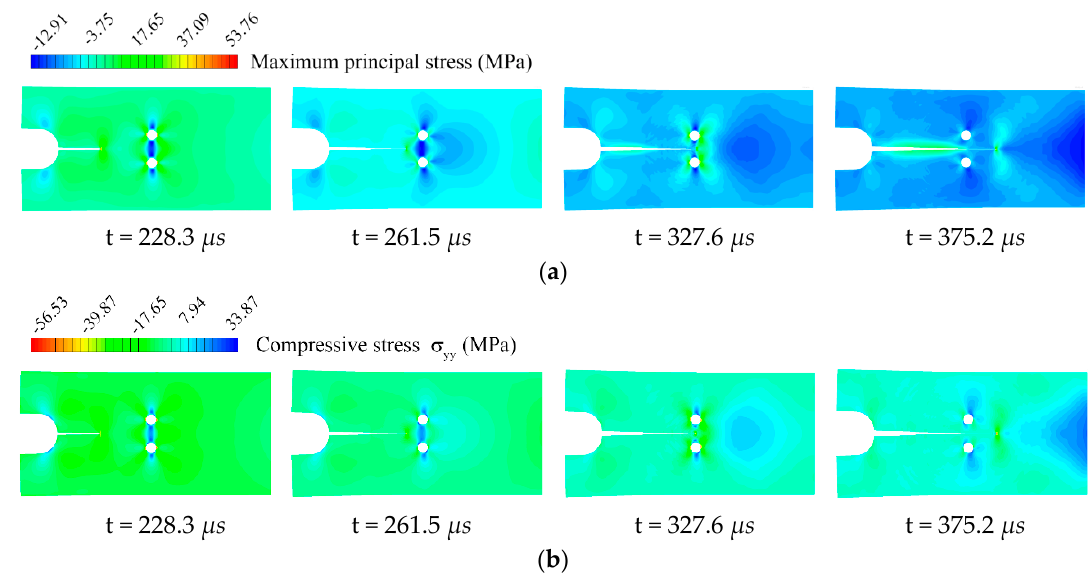
Figure 14. Numerical (AUTODYN) results of B16-D30 specimen. ( a ) Contour plot of the maximum principal stress. ( b ) Contour plot of the compressive stress σ yy .